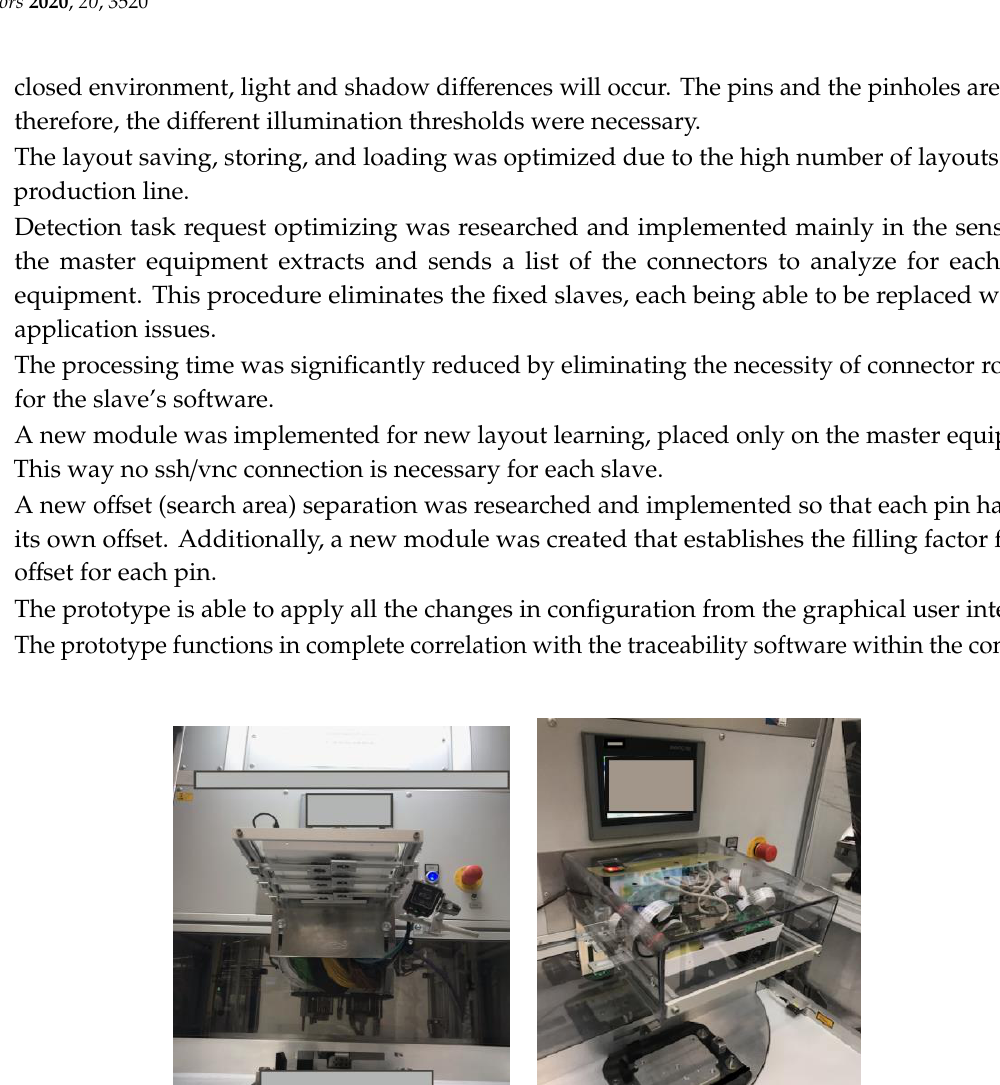
Figure 19. Final IP-LC-FD prototype ( a ) lower side view over the cameras installed on a specially created adjustable mechanical structure, ( b ) upper side view over the prototype installed on the operational machine.